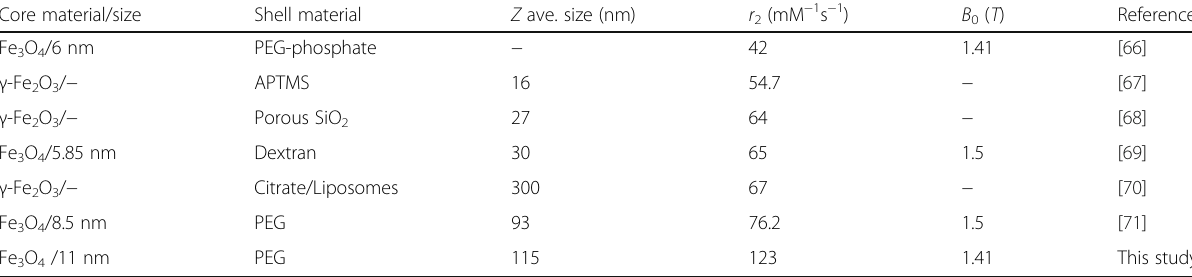
Table 1 Comparison of r 2 relaxivity with the current study Core